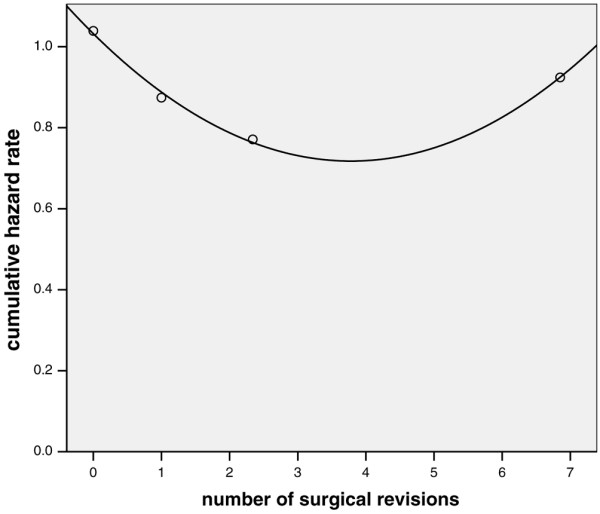
Univariate analysis of surgical efficacy versus cumulative hazard rate: first 150 days after inclusion. Shown is the univariate association between the number of surgical revisions (mean value per quartile) and the corresponding cumulative hazard rate for the first 150 days after inclusion. P < 0.001 after quadratic transformation of continuous data, and addition of a time-dependent covariate.